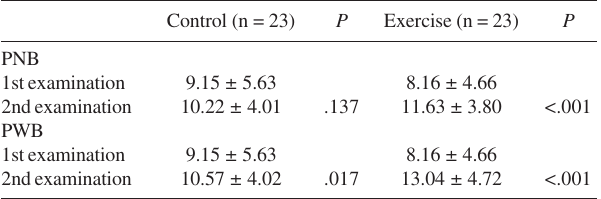
Table 5 - Results of perineometry with (PWB) and without (PNB) biofeedback obtained for the 46 pregnant women (control and exercise groups) at the first and second examinations (HCFMUSP, November 2003 to December 2004).